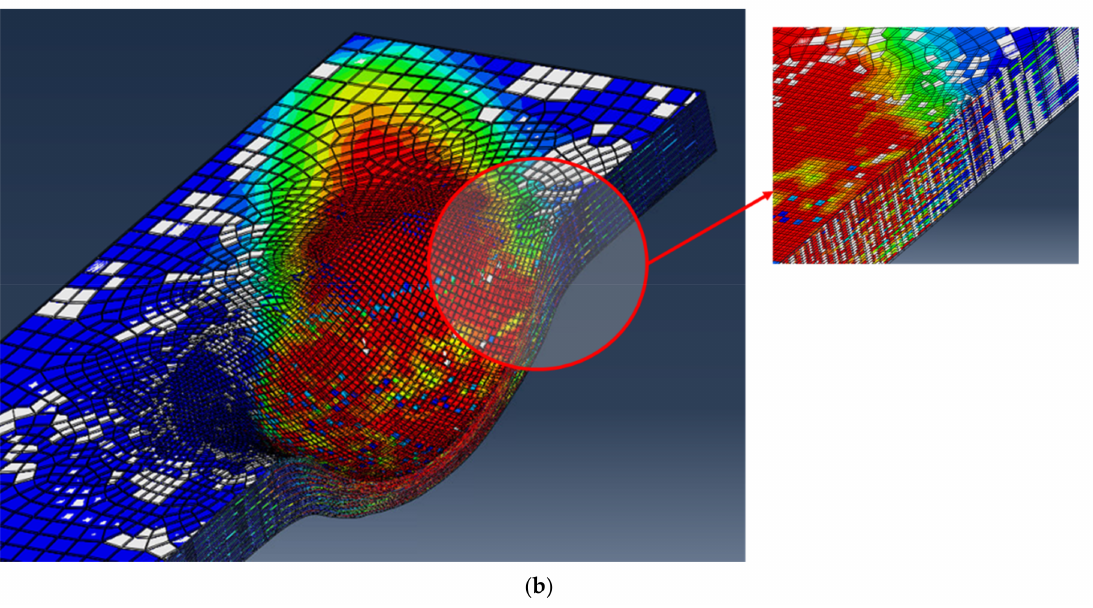
Figure 15. Damage contour with delamination through the thickness of the cross-section of the ( a ) [ 0/90/90/0 ] , and ( b ) [ 0/90/ + 45/ − 45 ] 8 s 8 s